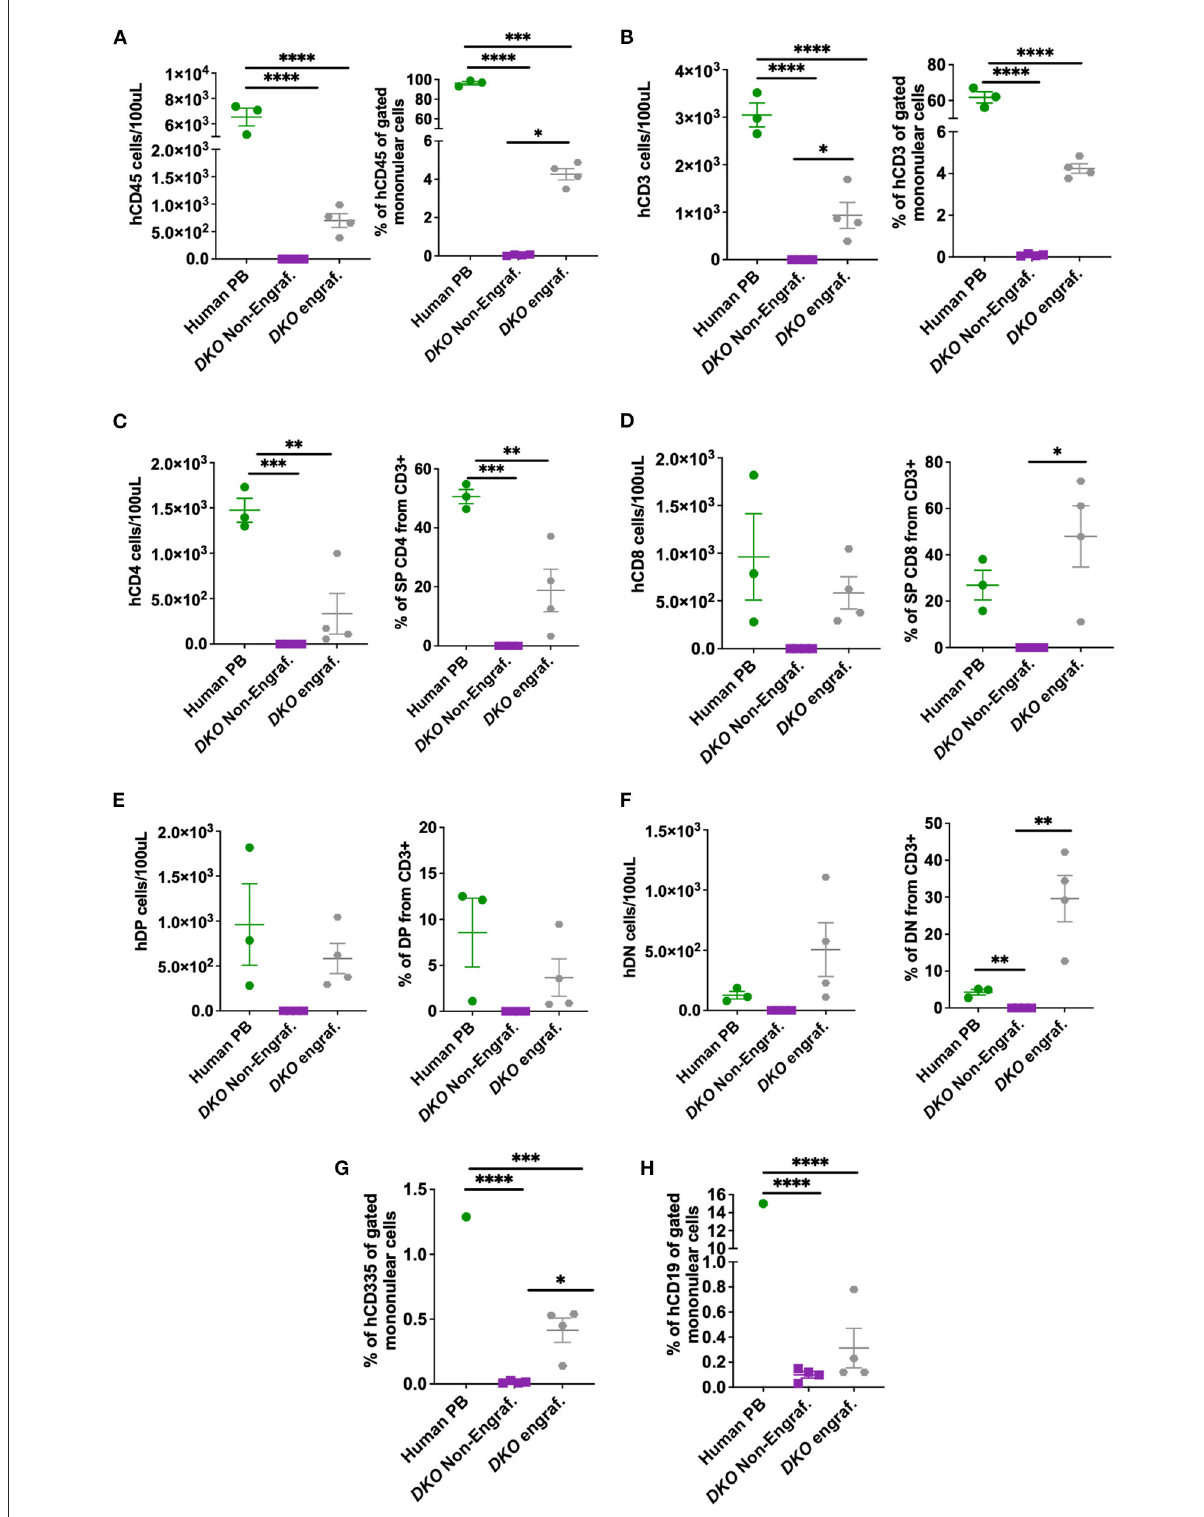
FIGURE6 Cell number and percentage quantification of cord blood flow cytometry data from DKO xenografted pigs. (A–F) Scatter plot showing number of human cells/100 µ L and percentage from mononuclear cell (from CD3 + for T subsets) or pig cord blood for human CD45, human CD3, human CD4, human CD8, human double positive (hDP) and human double negative (hDN) T -cells. Human blood served as positive control while the blood of non-injected DKO pigs served as a negative control. The line represents the mean, and adjusted p values are represented for Tukey’s multiple comparisons tests one-way ANOVA with a significance value of P < 0.05. (G,H) Scatter plot showing human CD335 and CD19 percentage from mononuclear cells. * P < 0.05, ** P < 0.01, *** P < 0.001, **** P <